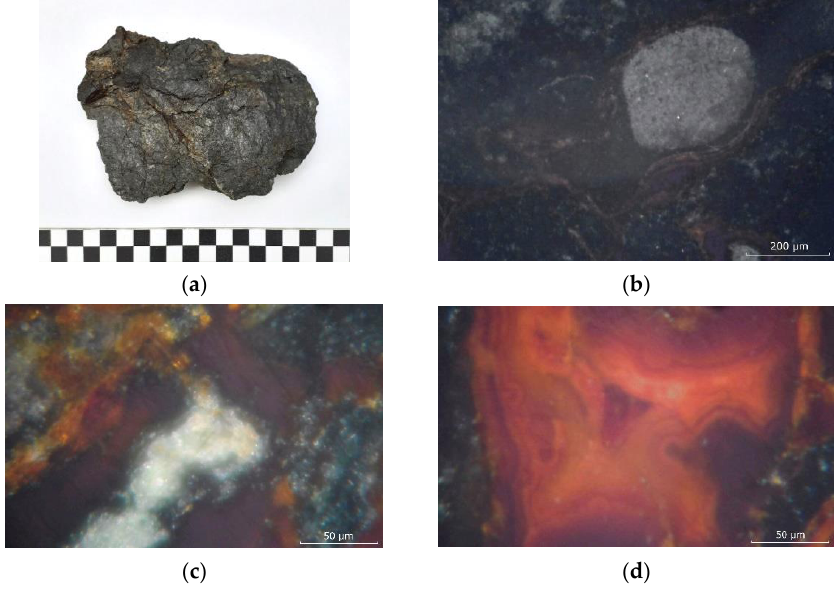
Figure 5. Temesa 2: ( a ) rock sample; ( b ) metal sulfides nodule (reflected light micrograph, crossed polarizers); ( c ) goethite veins surrounding quartz microcrystal (reflected light micrograph, crossed polarizers); ( d ) colloidal goethite (reflected light micrograph, crossed polarizers).